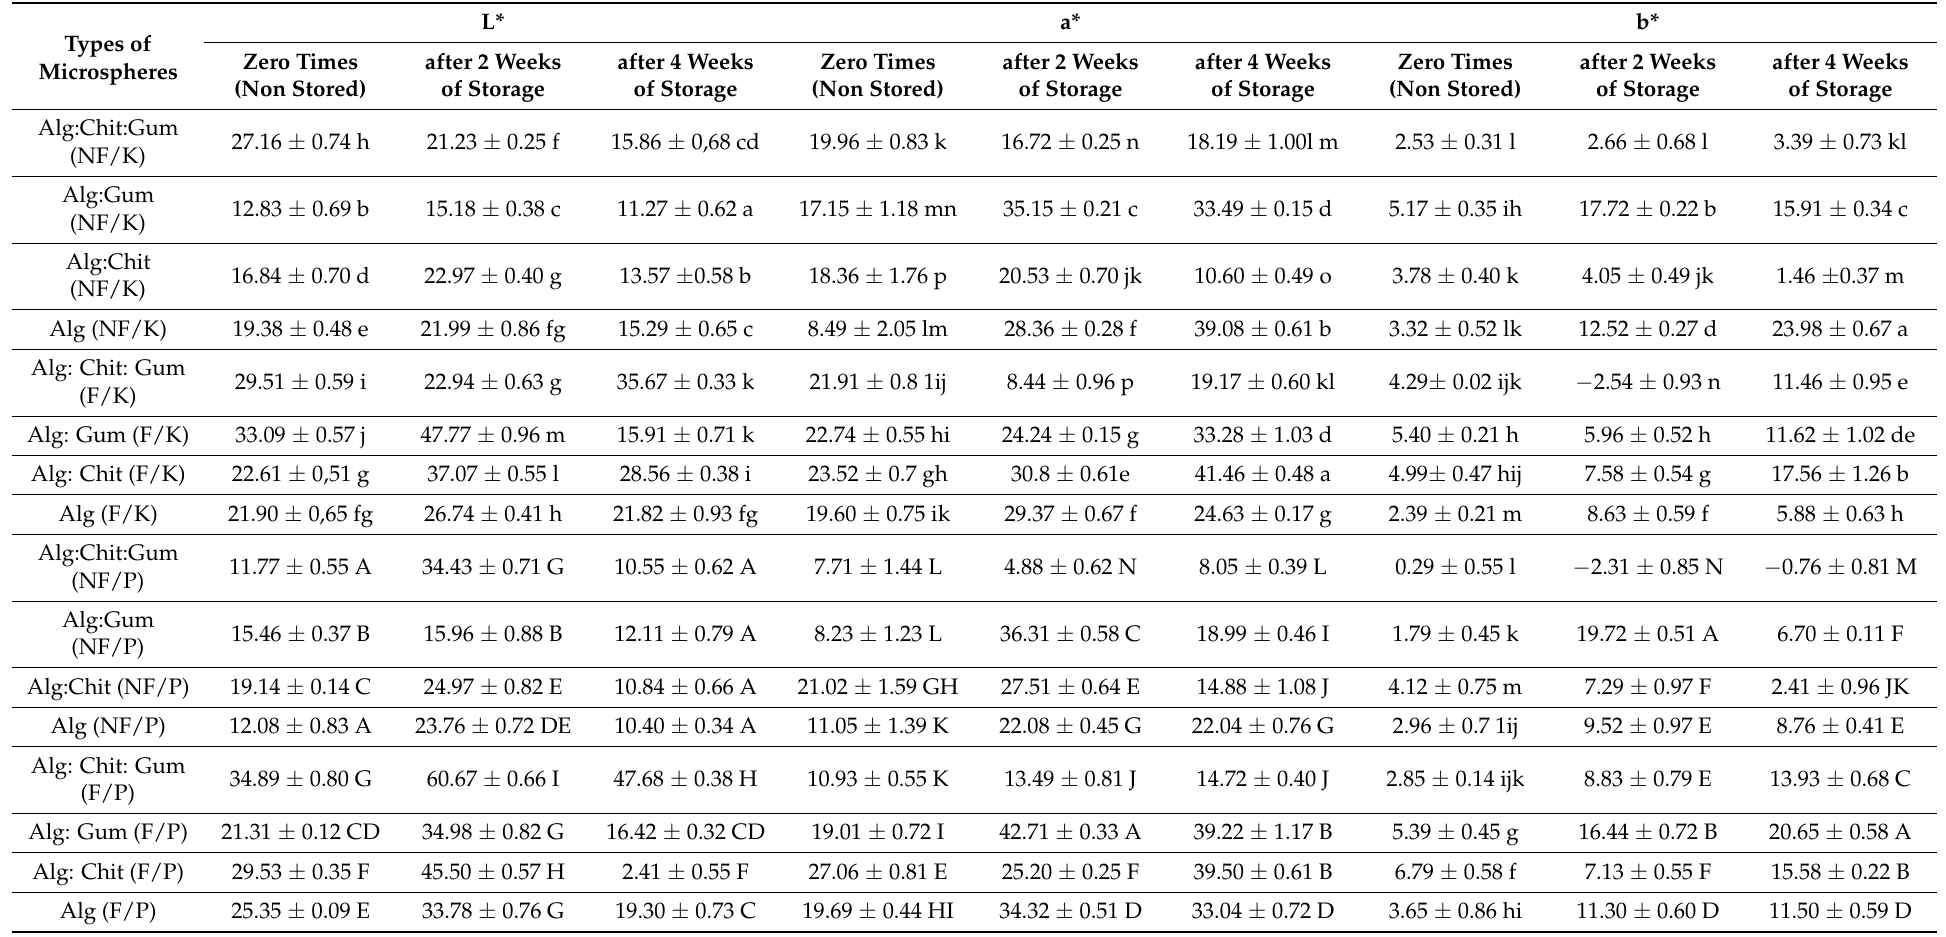
Table 5. Color measurement parameters for